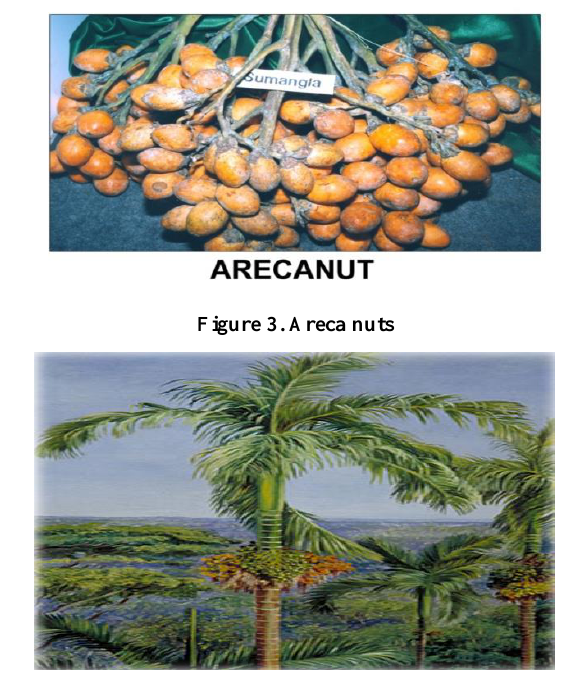
Figure 4. Areca catechu palm